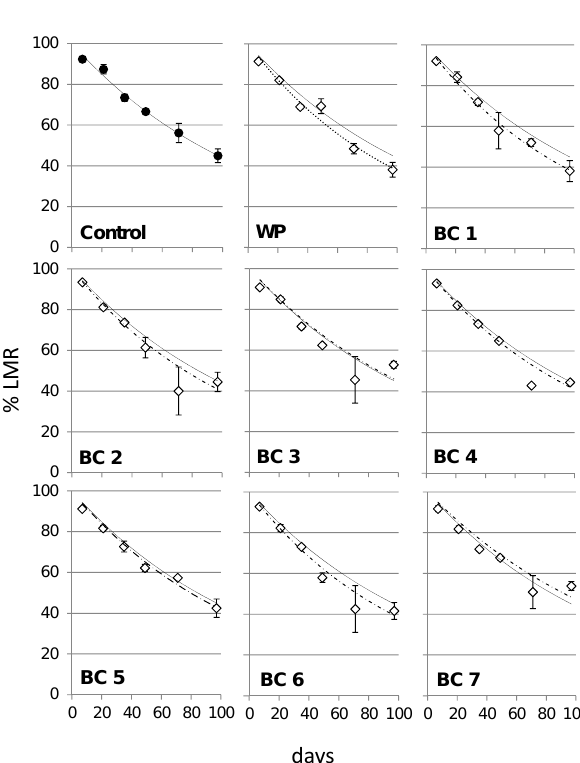
Figure 1. Average percent litter mass remaining (%LMR), over days of incubation, by treatments given in Table 1. Modeled ex- ponential decay curves are shown for each treatment (broken lines) compared to control (solid line). Bars indicate one standard error of the mean ( n = 3 or n = 9; see